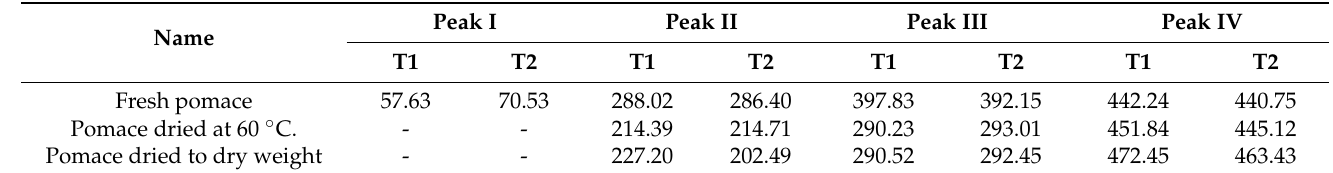
Table 6. Peak maximum temperatures ( ◦ C) for apple-pomace samples based on the obtained DSC curves. Analysis in an oxygen atmosphere.